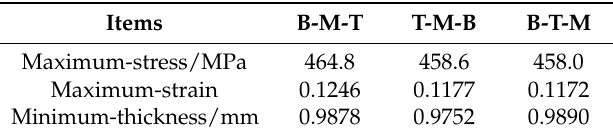
Table 2. Stress, strain, and thickness results of three spinning processes.